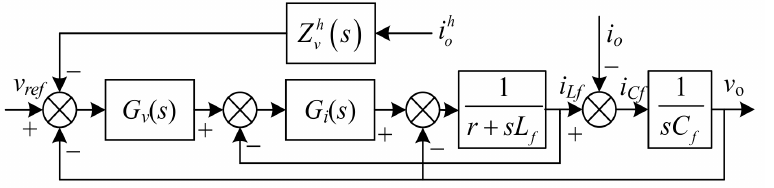
Figure 5. Voltage and current double closed-loop control with h -order virtual harmonic